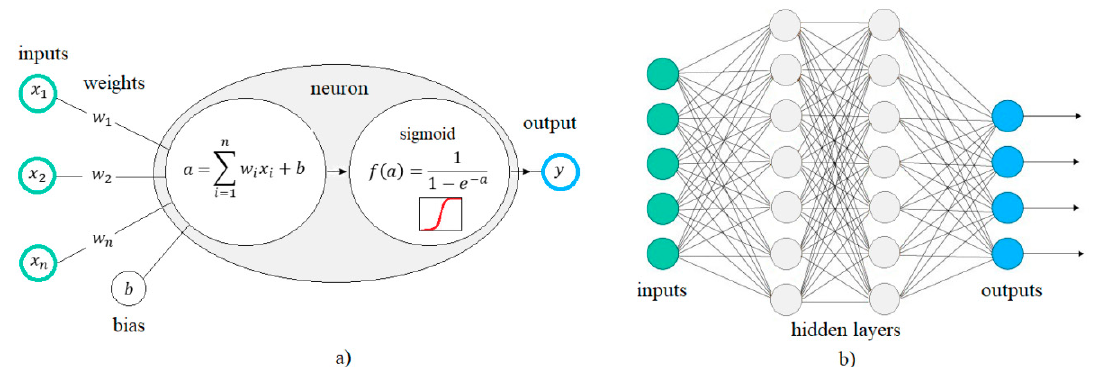
Figure 1. Architecture of various types of neural networks. Reprinted from [10] with permission from F.Van Veen & S. Leijnen.